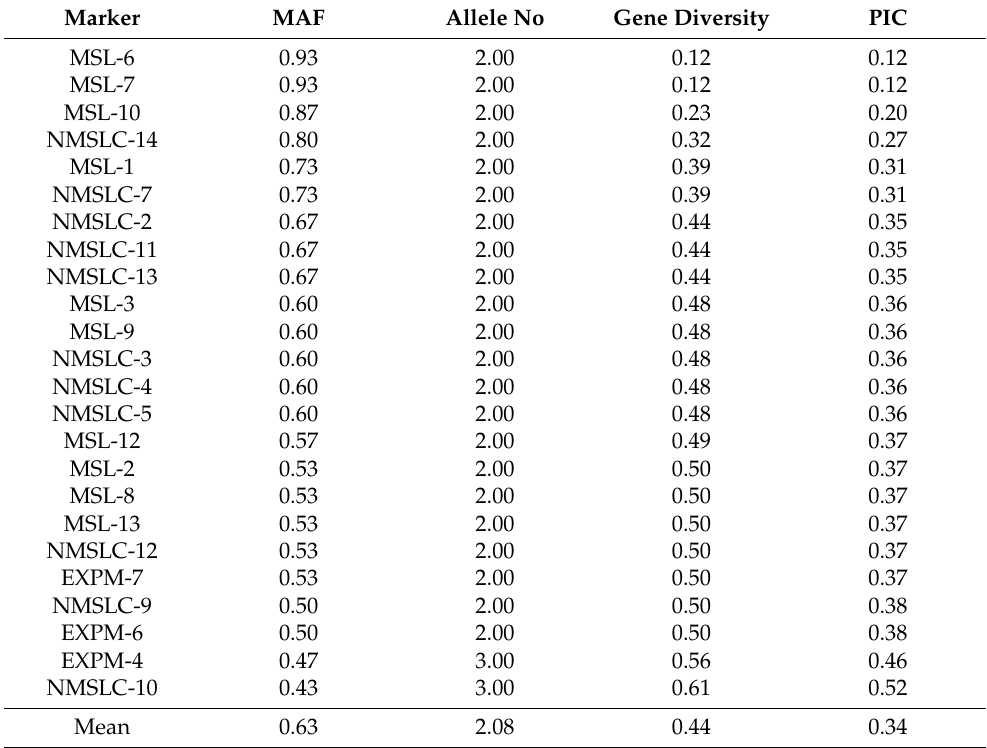
Table 4. Major allele frequency (MAF), gene diversity, heterozygosity, and polymorphism information content (PIC) of the 24 SSR